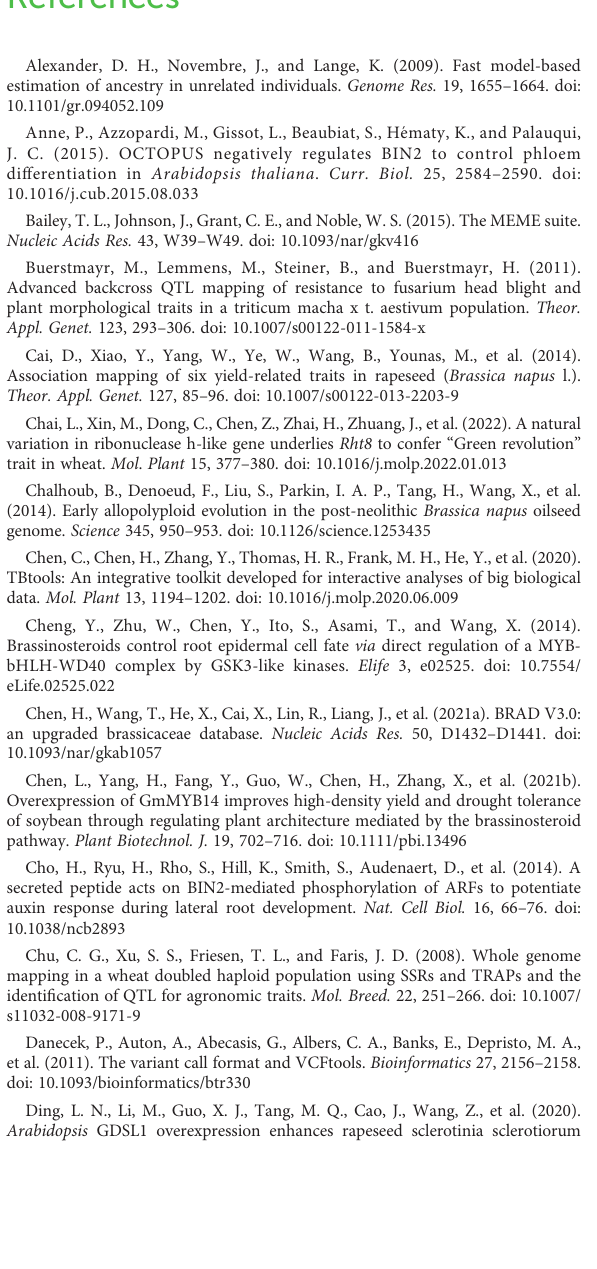
SUPPLEMENTARY FIGURE 1 Phenotype distribution and correlation of plant height in two consecutive years in B. napus . (A) Phenotype distribution of plant height in 2017-2018, 2018-2019, and BLUP. (B) Correlation of plant height between 2017-2018 and 2018-2019. SUPPLEMENTARY FIGURE 2 Population structure of 230 B. napus accessions. (A) Cross − validation error under different K values. (B) Model-based population structure under K = 9. The y axis represents clusters memberships and the x axis represents the 230 B. napus accessions. (C) Relative kinship of 230 rapeseed accessions. SUPPLEMENTARY FIGURE 3 Quantile-quantile plots of GWAS in two consecutive years under three